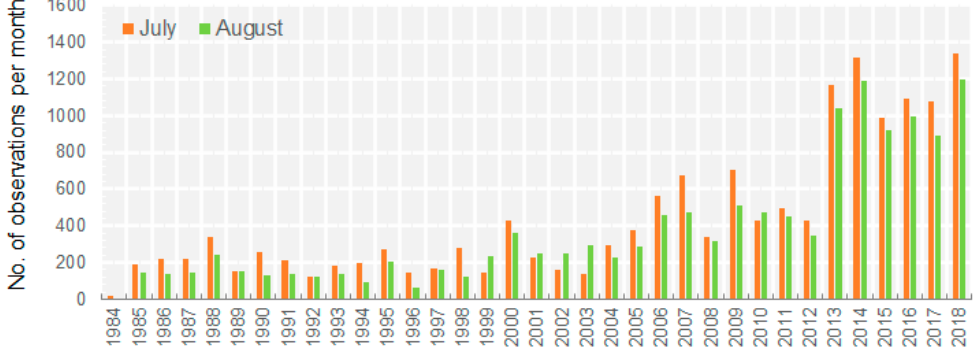
Figure 2. Number of Landsat scenes using the selection criteria per month (July or August) over the entire study area during the observation period.